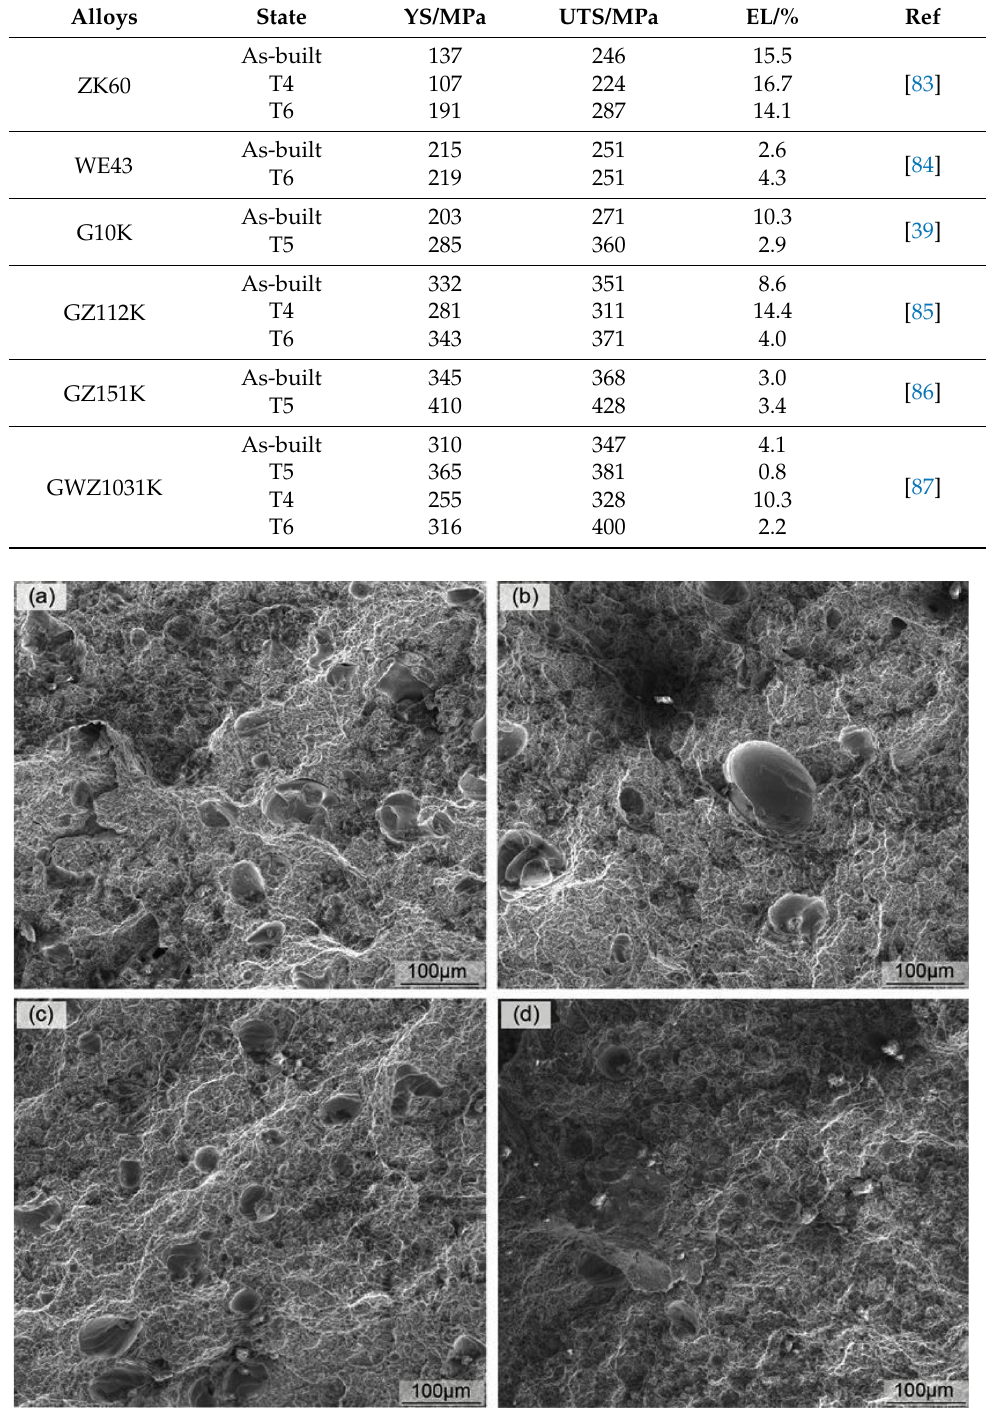
Figure 11. Fracture topography of SLMed AZ91D at different energy densities ( a ) 166.7 J/mm 3 , ( b ) 142.9 J/mm 3 , ( c ) 111.1 J/mm 3 , ( d ) 83.3 J/mm 3 . Reprinted with permission from ref. [47]. Copyright 2022 Copyright 2014 Elsevier..